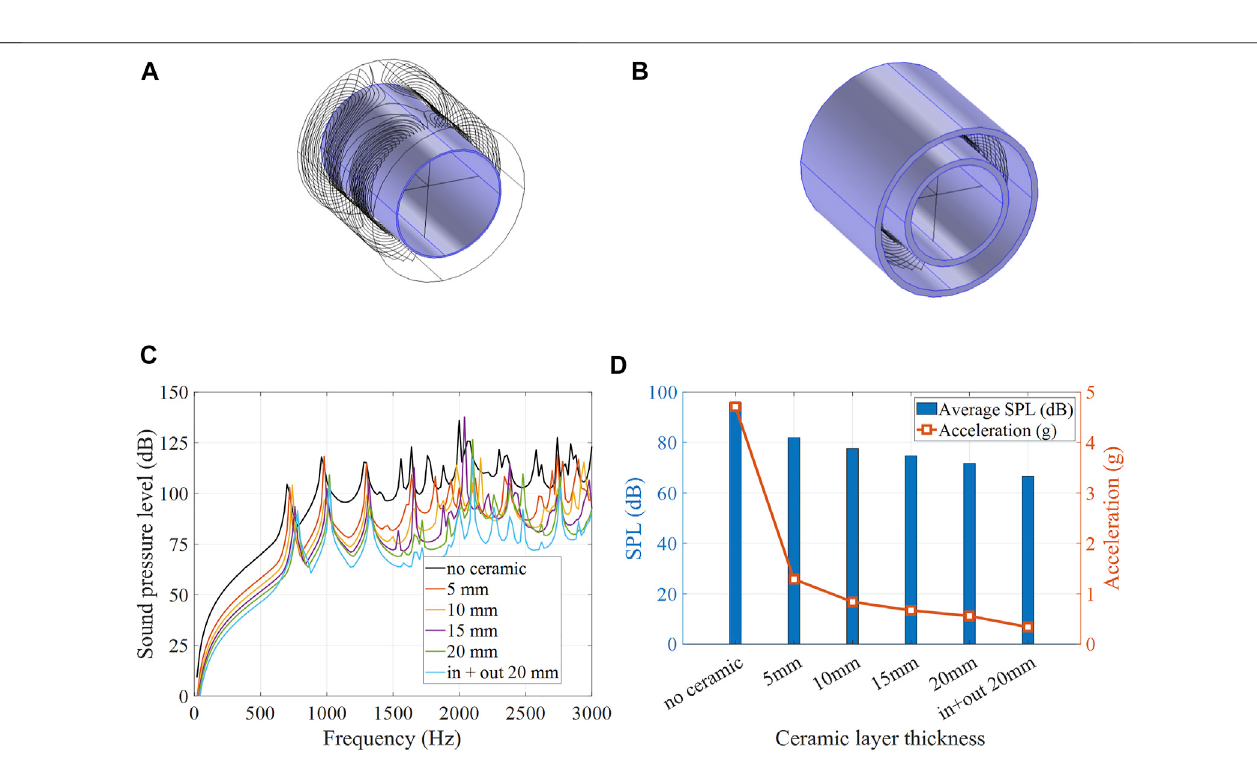
Frontiers in Physics |